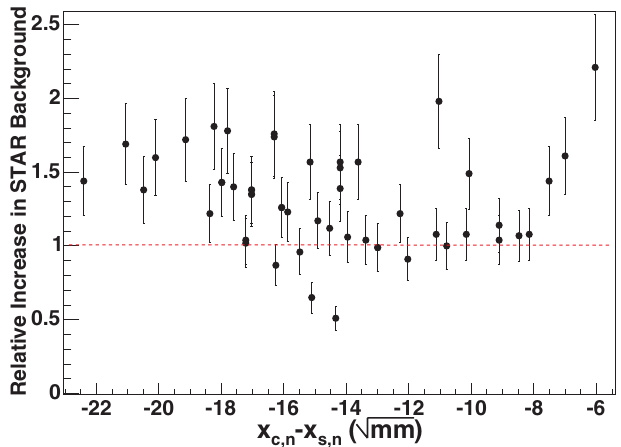
FIG. 13. (Color) The relative increase of the STAR background vs the relative normalized position between the crystal and the scraper during Fill 03061. The red line indicates where the crystal collimated background equals the collimated back- ground. The error bars are